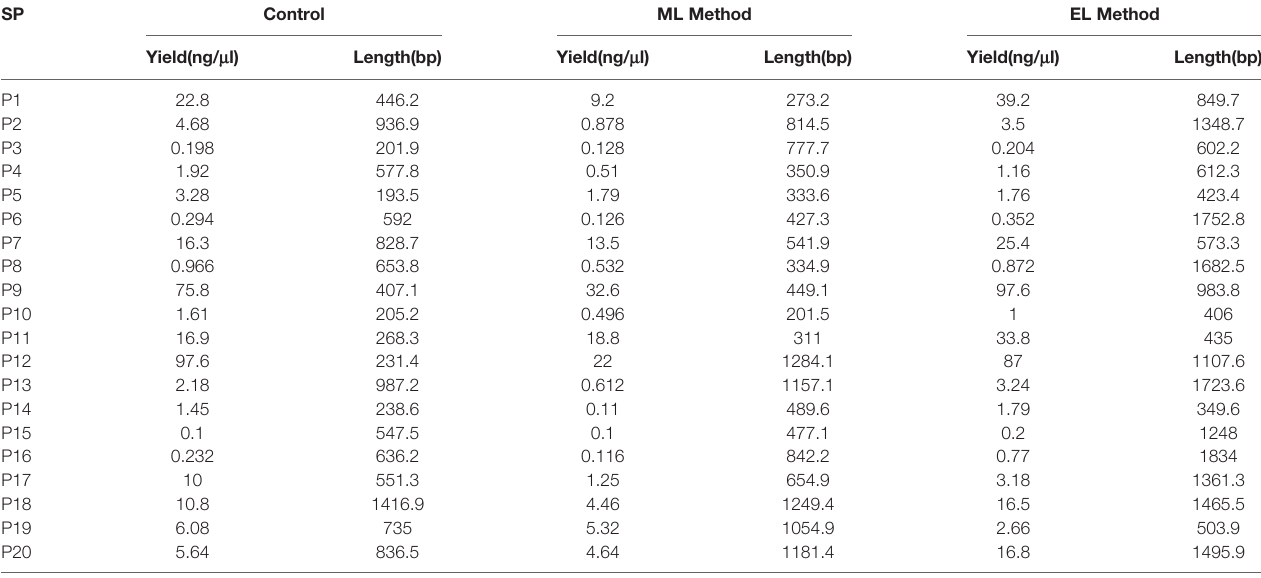
TABLE 1 | DNA yield and integrity of the three DNA extraction methods. SP Control ML Method EL Method